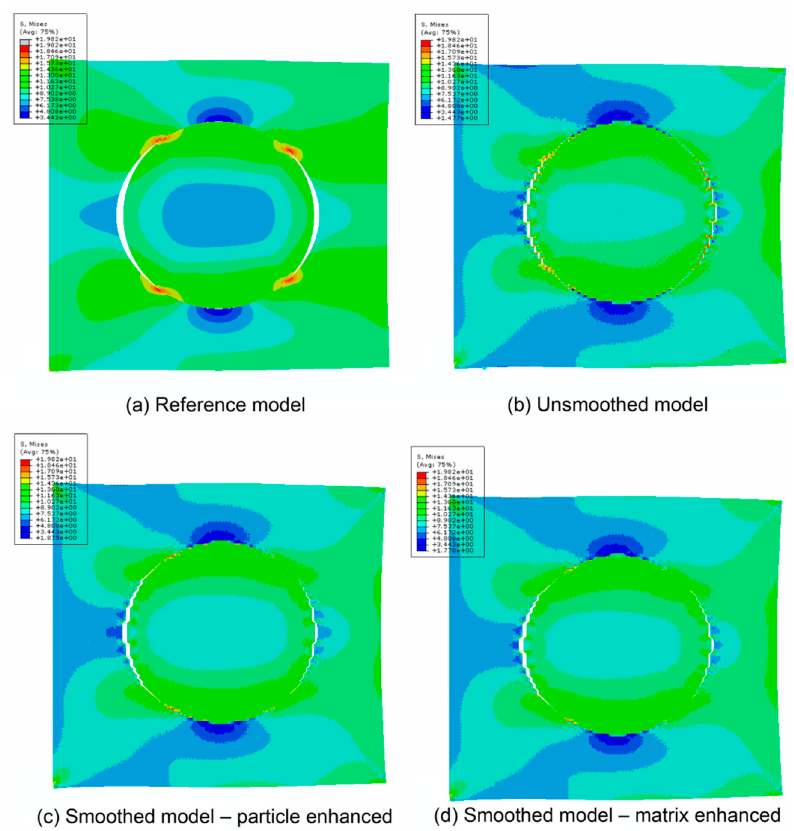
Figure 11. Cracks due to debonding and von Mises stress distributions: ( a ) reference model; ( b ) unsmoothed model; ( c ) smoothed model-particle enhanced; ( d ) smoothed model-matrix enhanced.